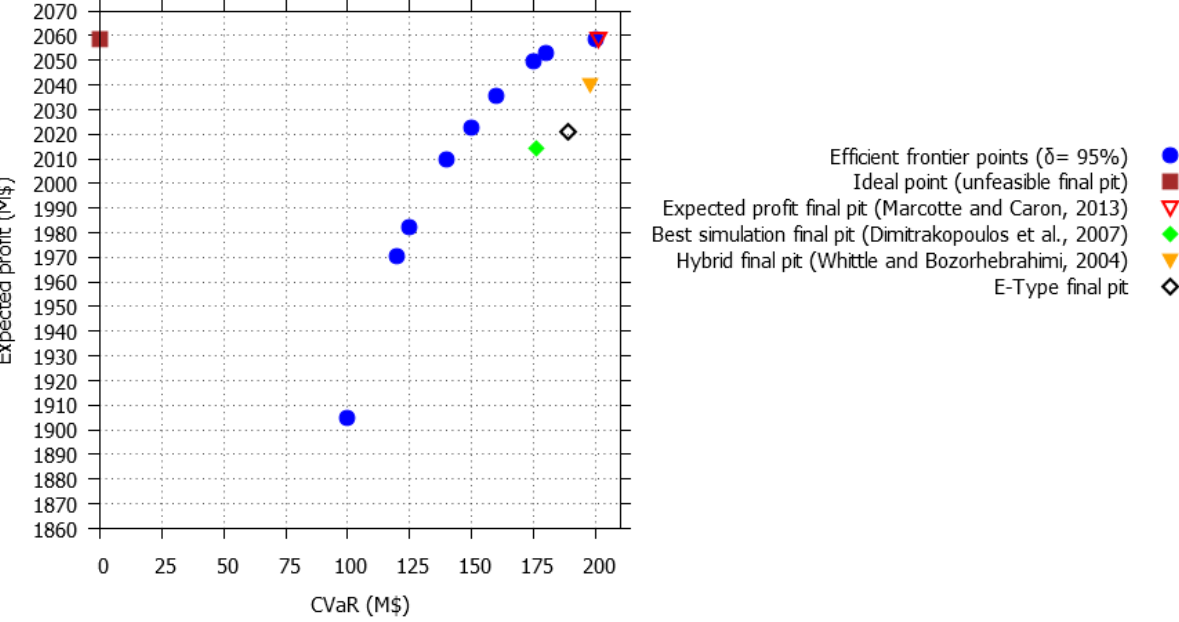
Table 2. A comparison among several final pits alternatives in terms of expected profit and risk